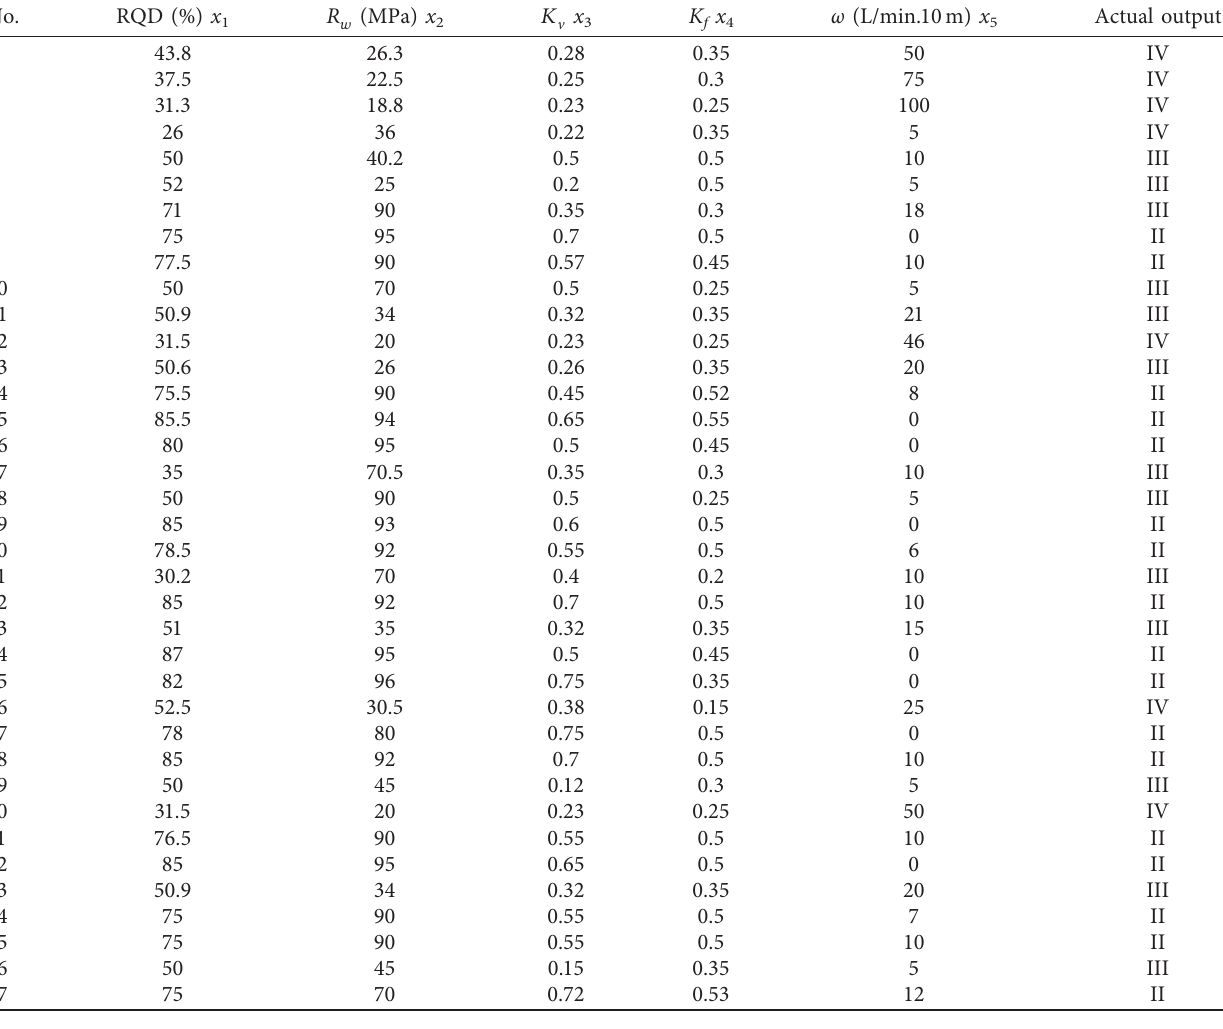
Table 1: The collected samples.